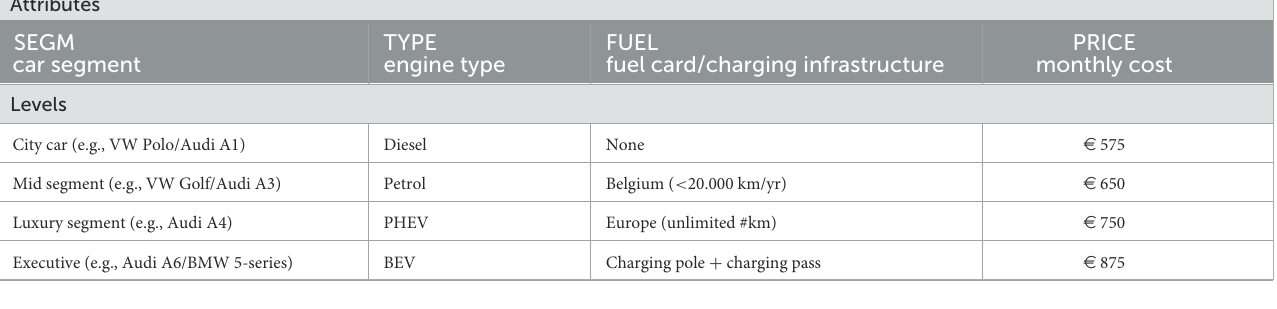
TABLE 1 Attributes and levels of the CBC design.